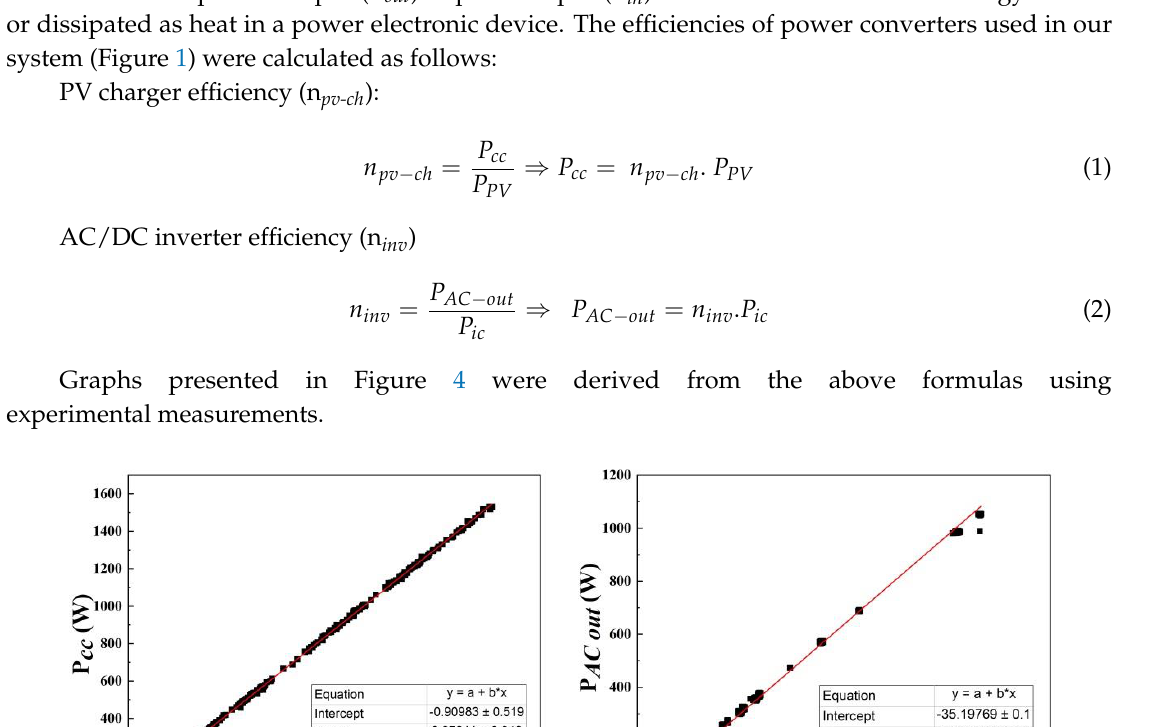
Figure 3. A nearly symmetric comparison between experimental measurements and the PV model output.